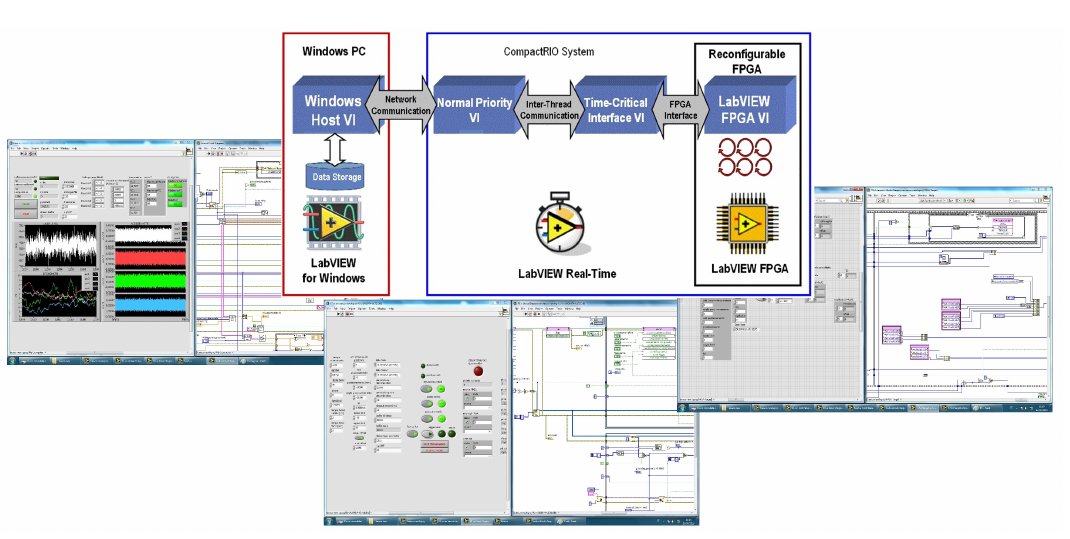
Figure 10. LabView program